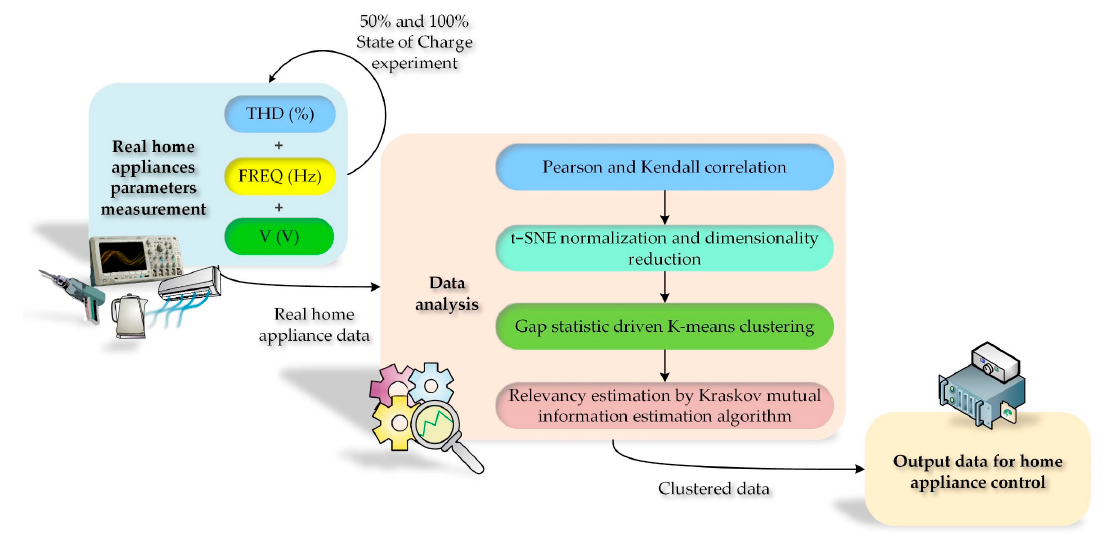
Figure 1. Diagram showing the scope of research presented in this article.